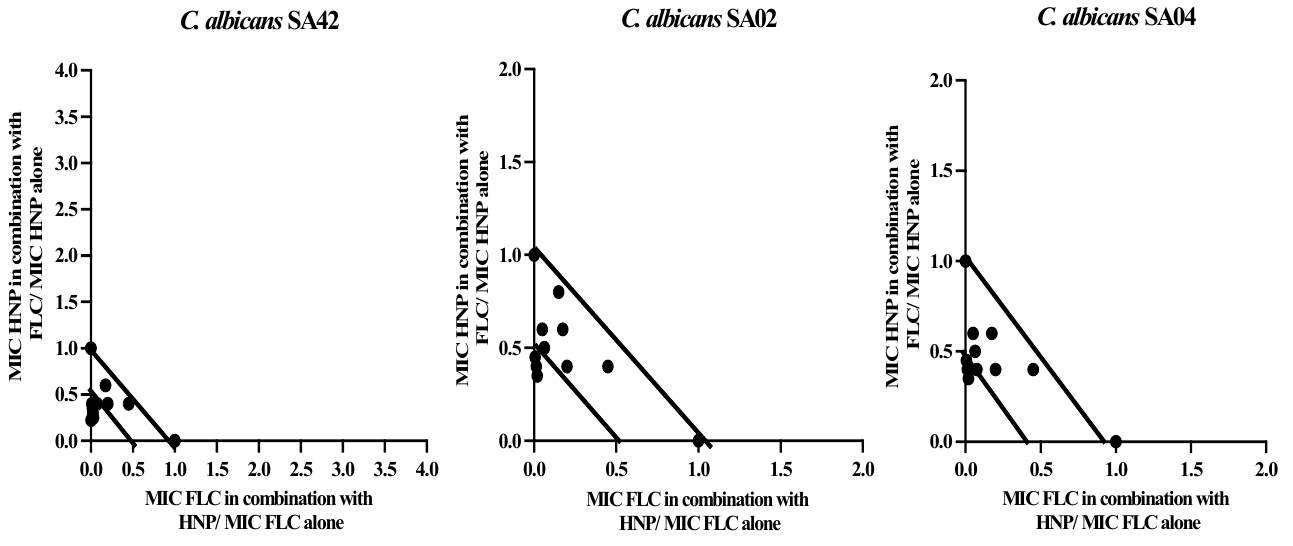
Figure 1. Isobolograms. The figure represents the synergistic and additive effects of nine different ratio combinations between human neutrophile peptide and fluconazole against fluconazole-susceptible C. albicans SA42 and fluconazole-resistant C. albicans SA02 and SA04.